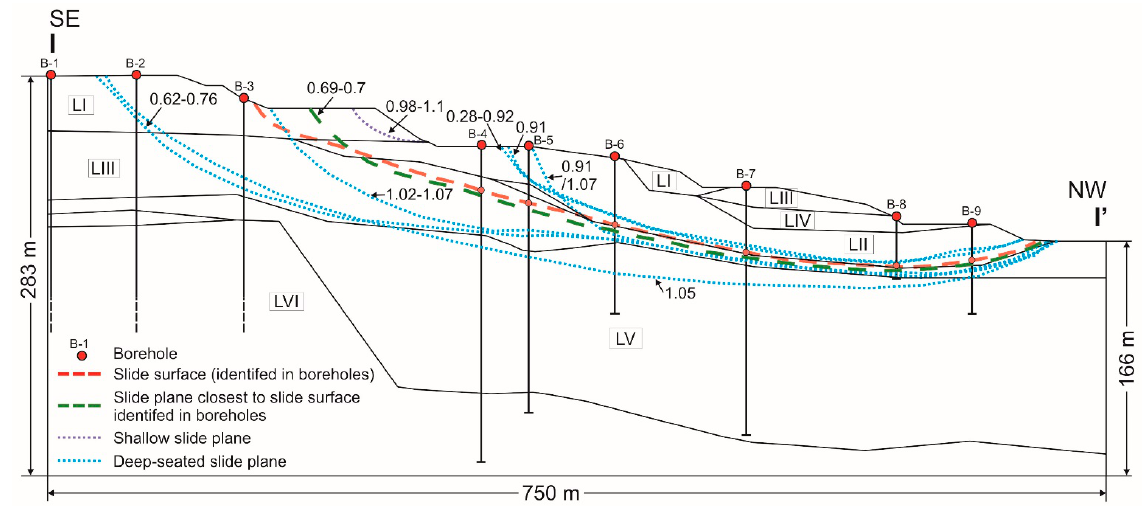
Figure 12. Location of the generalised slide planes with assigned factors of safety less than 1.1 and slide surface identified in boreholes.